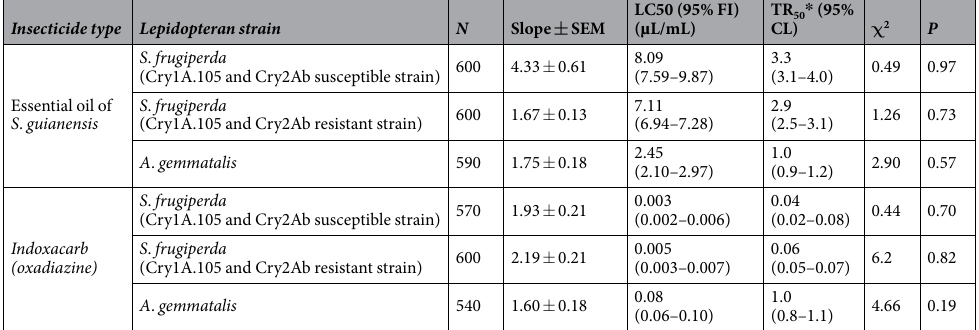
Table 2. Relative susceptibility of key lepidopteran pests (i.e., S . frugiperda and A . gemmatalis ) to the essential oil of S . guianensis and the synthetic insecticide indoxacarb (oxadiazine). * Tolerance ratio estimated by dividing the LC 50 value obtained for S . frugiperda strains by the LC 50 value obtained for A . gemmatalis